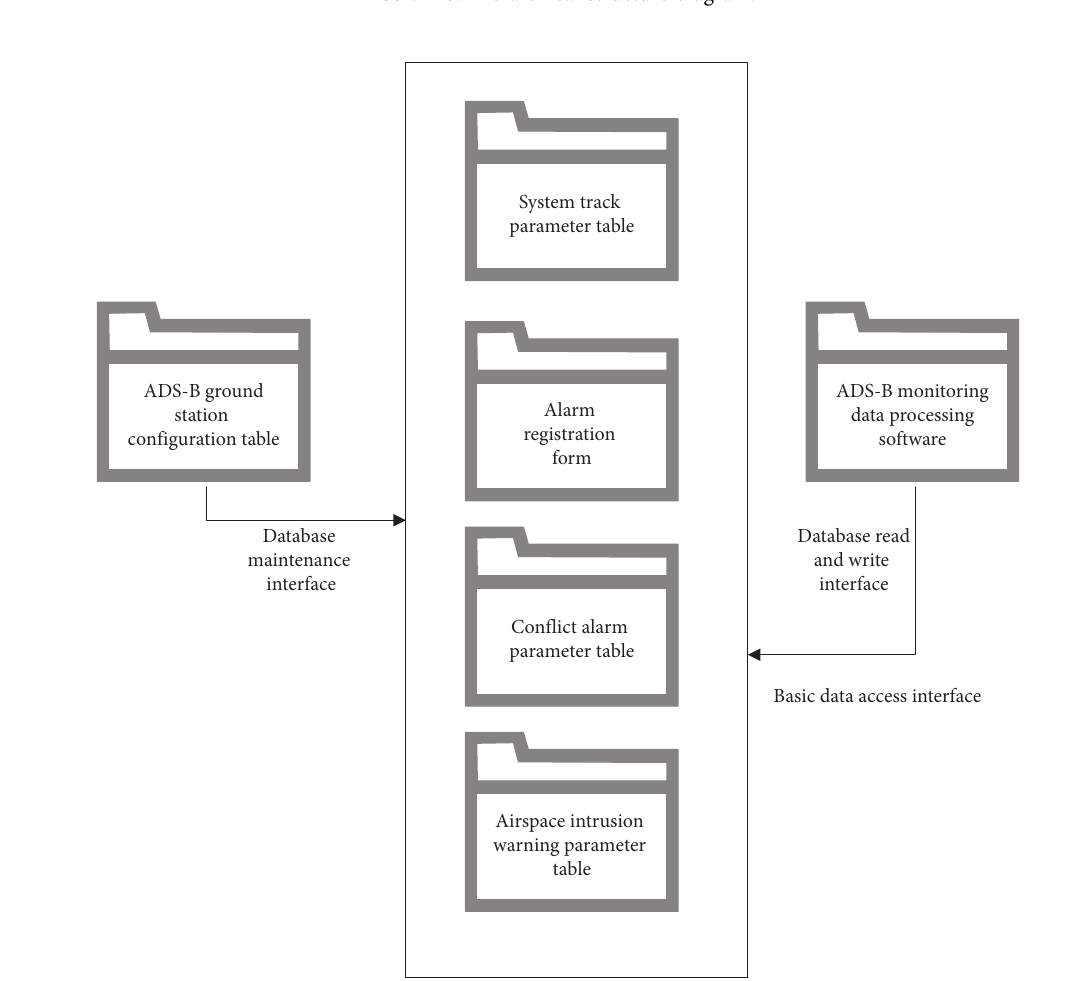
Figure 11: Database structure